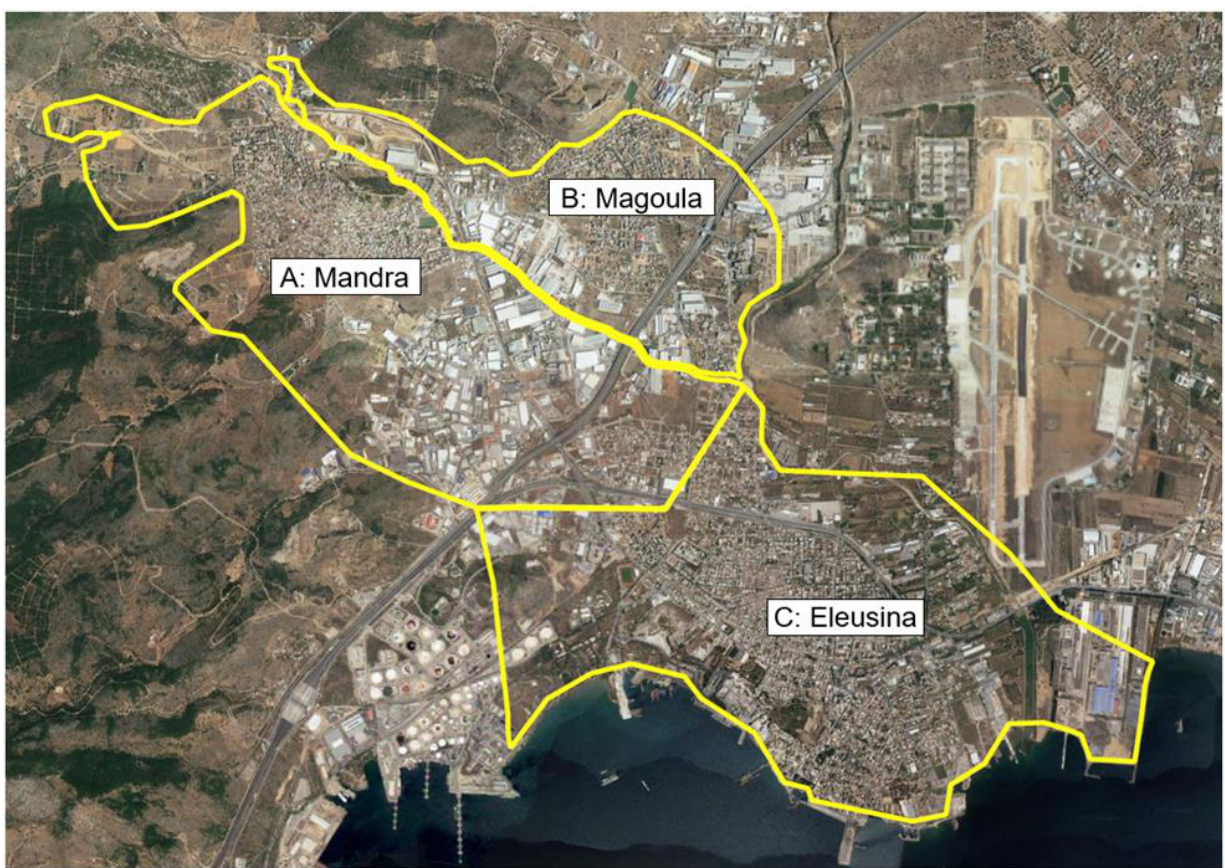
Figure 2. The boundaries of the computational domain and the three main areas (Google Maps).